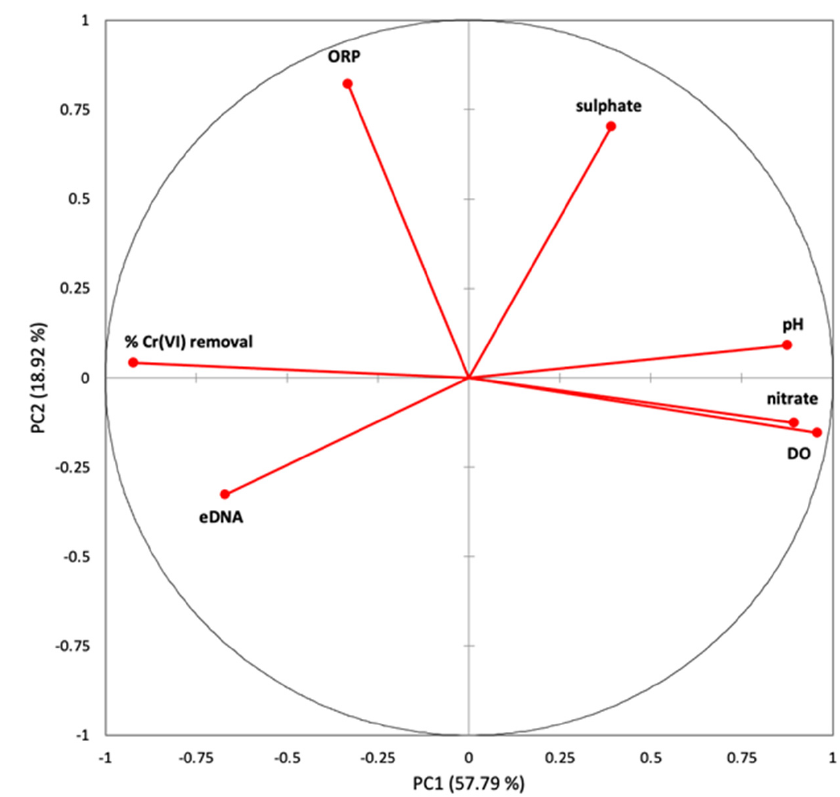
Figure 4. Distribution of the variables in the space of the two principal components.